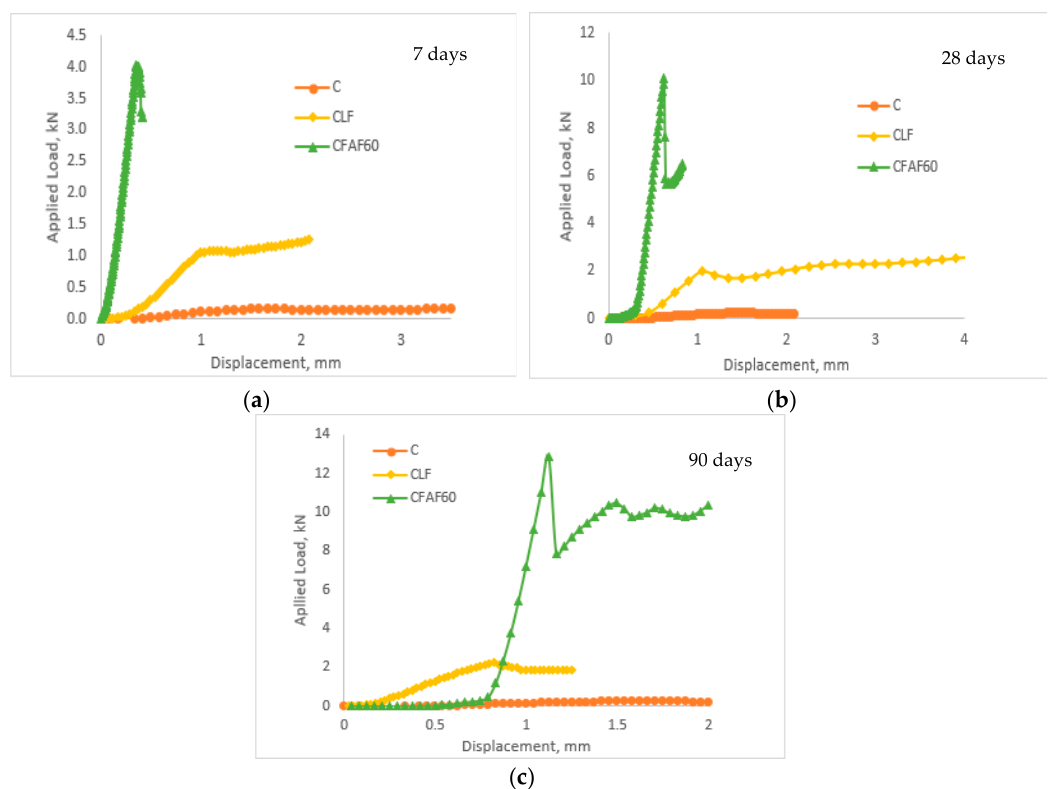
Figure 5. Load versus displacement (indirect tensile strength) for ( a ) 7 days, ( b ) 28 days, and ( c ) 90 days.